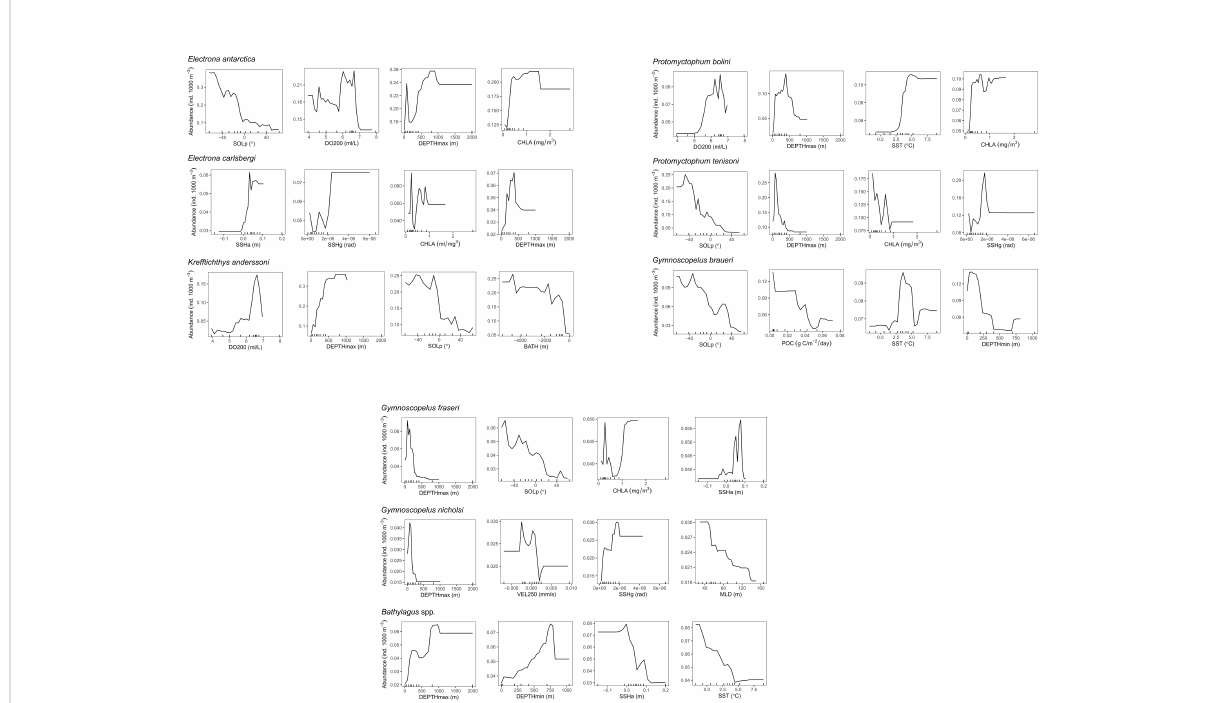
FIGURE 3 Partial dependence plots showing the effect of environmental covariates (horizontal axes) on the predicted abundance (vertical axes) of eight myctophid species and the genus Bathylagus , after accounting for the effects of all other variables in the boosted regression tree model. Tick marks inside the plots along the horizontal axes represent the distribution of data points used to build the model. Only the four most in fl uential predictors for each taxonomic group are shown, ordered by level of importance from high to low. The full names and a description of all environmental covariates are given in Table